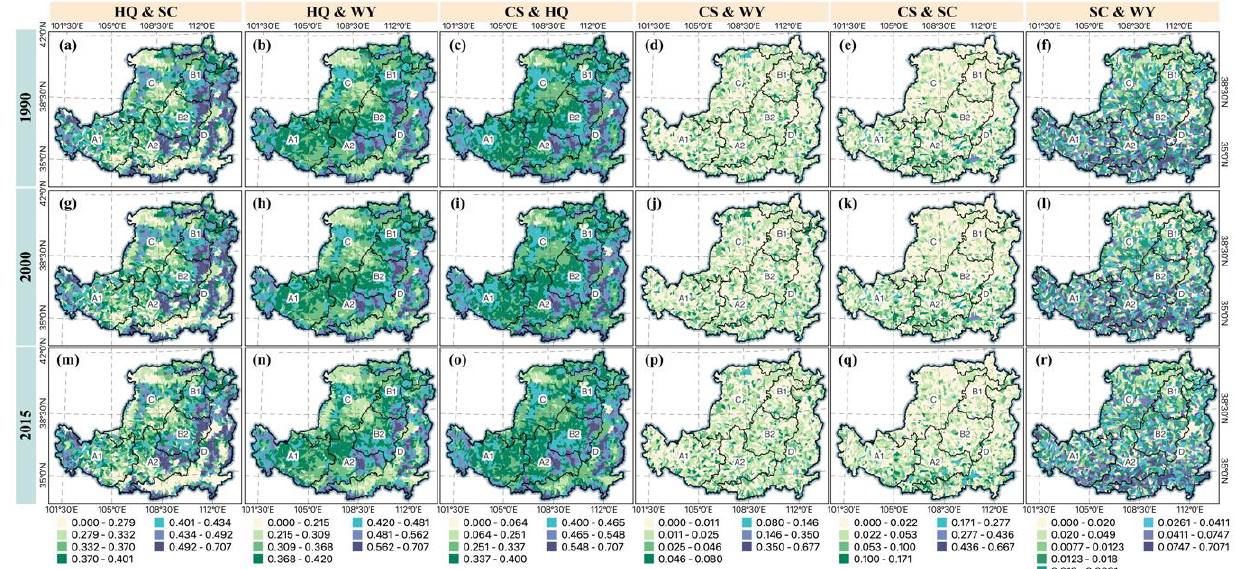
Figure 7. Trade-offs/synergies change between ecosystem services in the LP, 1990, 2000, and 2015. Trade-offs/synergies between HQ & SC in 1990 ( a ), HQ & WY in 1990 ( b ), CS & HQ in 1990 ( c ), CS & WY in 1990 ( d ), CS & SC in 1990 ( e ), SC & WY in 1990 ( f ), HQ & SC in 2000 ( g ), HQ & WY in 2000 ( h ), CS & HQ in 2000 ( i ), CS & WY in 2000 ( j ), CS & SC in 2000 ( k ), SC & WY in 2000 ( l ), HQ & SC in 2015 ( m ), HQ & WY in 2015 ( n ), CS & HQ in 2015 ( o ), CS & WY in 2015 ( p ), CS & SC in 2015 ( q ), SC & WY in 2015 ( r